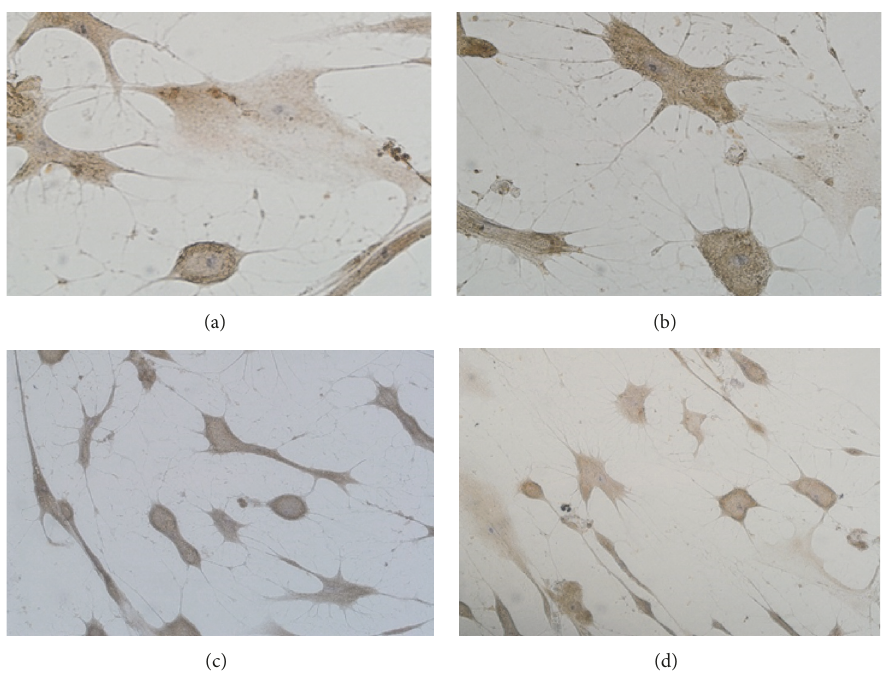
Figure 3: Immunostaining images showing the effect of resveratrol (15.0 and 30.0 mg/L) on neuron markers nestin and NSE on hUC-MSCs. (a) Nestin and (b) NSE immunochemical staining of hUC-MSCs treated with resveratrol at a concentration of 15.0 mg/L. (c) Nestin and (d) NSE immunochemical staining of hUC-MSCs treated with 30.0 mg/L